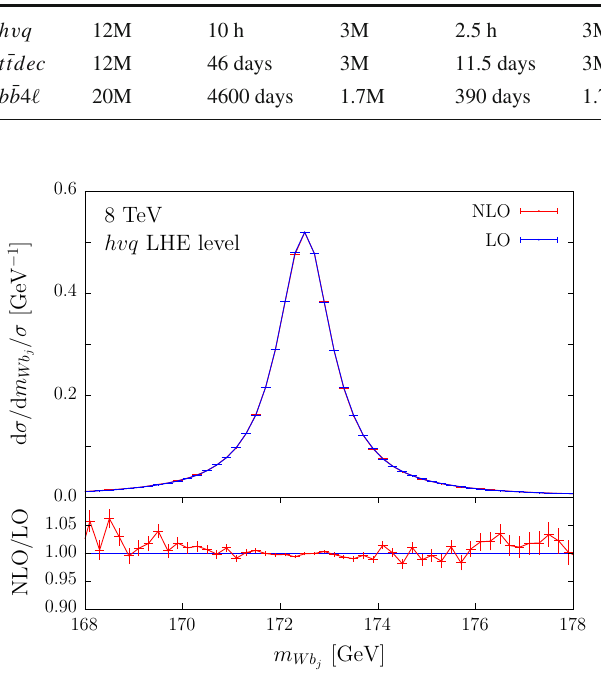
Fig. 3 d σ/ dm Wb distribution with NLO accuracy in production and j decay (red), only in production (green) and with LO accuracy (blue) obtained with the t ¯ tdec generator, normalized to 1 in the displayed range. In the bottom panel the ratio with the LO prediction is shown